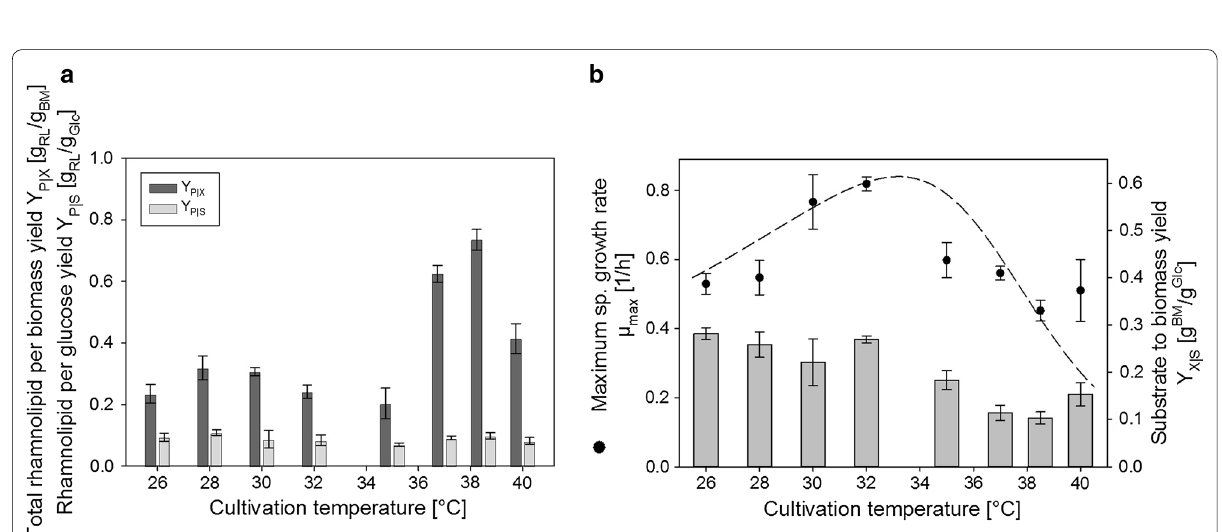
Fig. 4 Effect of temperature on rhamnolipid-per-glucose yields (Y P|S ) and rhamnolipid-per-biomass yields (Y P|X ) ( a ) as well as effect of temperature on maximum specific growth rate µ max and substrate-to-biomass yields (Y X|S ) ( b ). Maximum specific growth rate as a function of temperature was described using an equation proposed by Roels et al. (1983) (Eq. 2) with parameter fitting performed for the obtained data (dashed